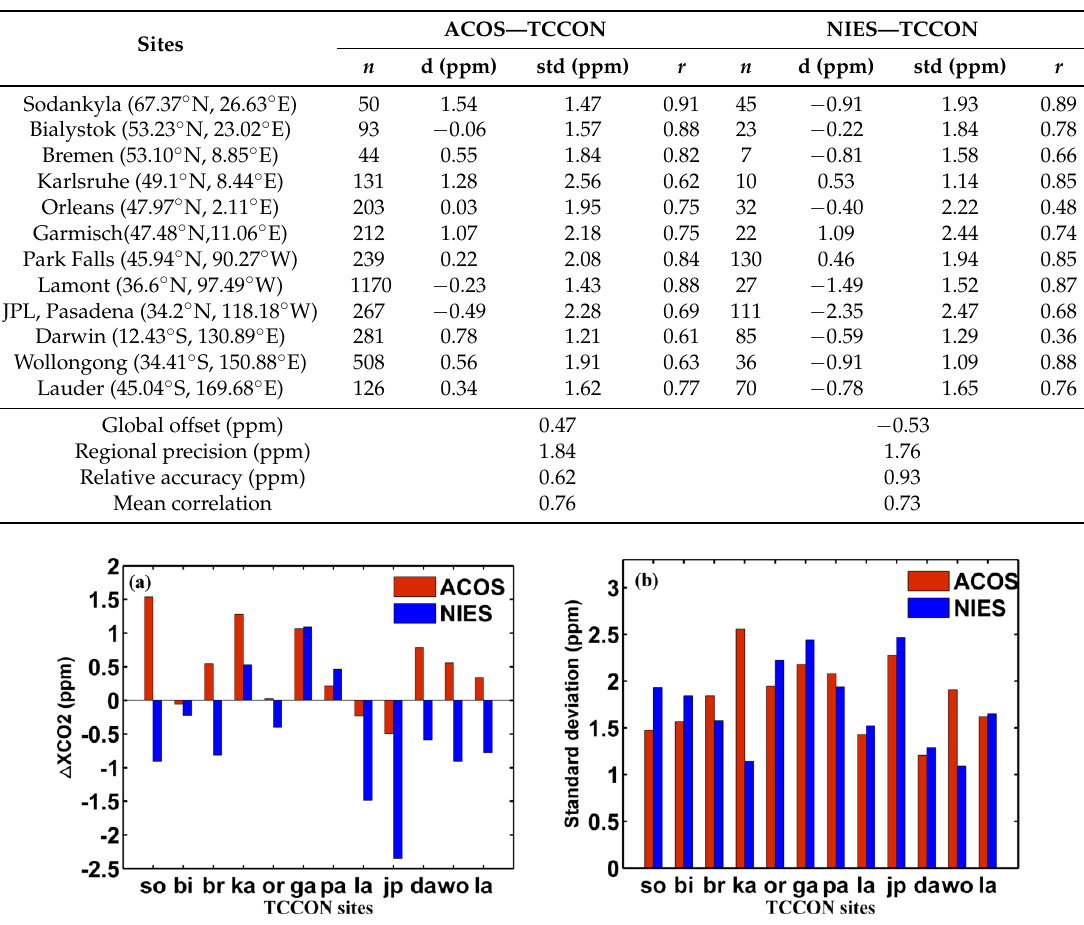
Table 1. Summary of comparison of ACOS and NIES XCO 2 versus TCCON observations. Shown are the coincided number n between satellite retrievals and TCCON data, the mean difference d (station bias) and standard deviation std of their difference, and the correlation coefficients r . The global offset, which is averaged d , the regional precision, which is averaged std, the relative accuracy, which is a standard deviation of d , and the mean correlation, which is averaged r , are also given at the bottom of the table.